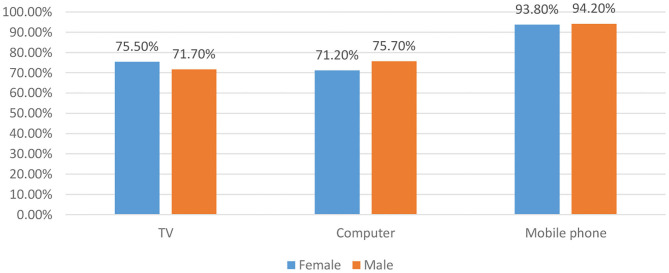
The proportion of participants using one of the three devices according to gender.